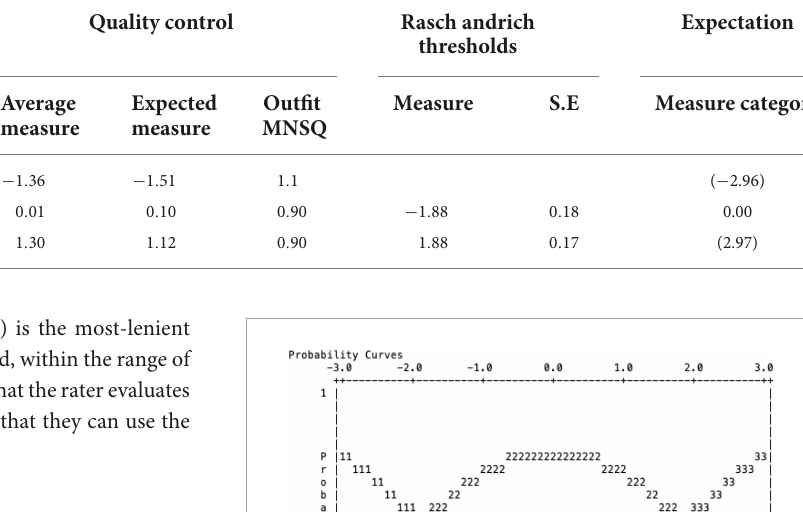
TABLE 6 Rating scale calibration.